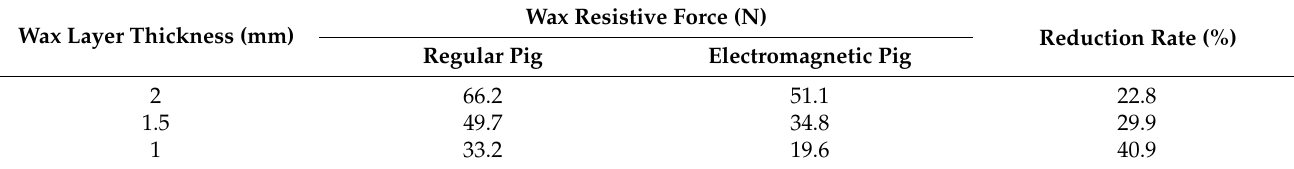
Table 3. Comparison of wax resistive forces of electromagnetic and regular pigs *.